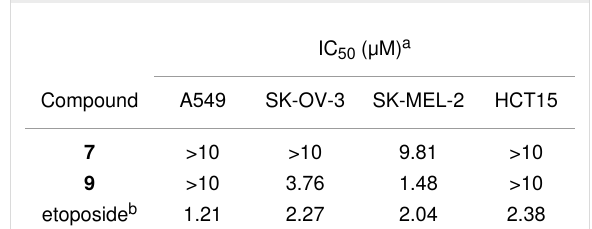
Table 6: Cytotoxic activities of selected compounds against four cultured human cancer cell lines in the SRB